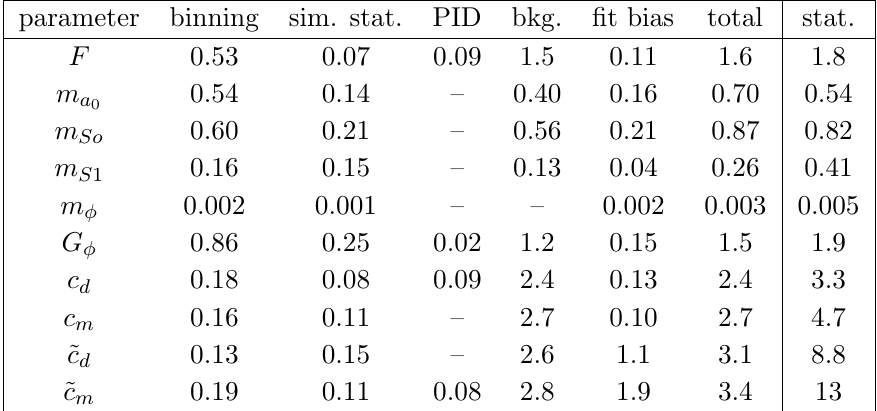
Table 6 . Systematic uncertainties (%) on the results of the Triple-M (cid:12)t. For comparison, the statistcal uncertainties are listed in the last column.